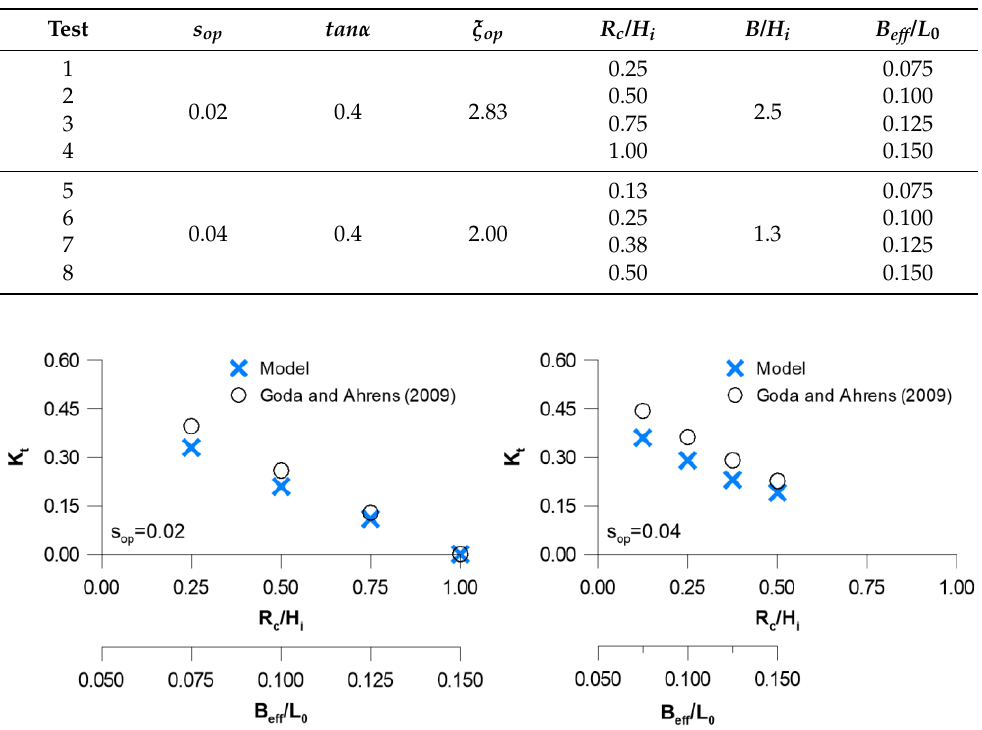
Figure 3. Governing parameters involved in wave transmission at emerged low-crested structures (LCS). Table 1. Values of the parameters in the wave transmission Tests ( s op = wave steepness; tan α = slope; ξ op = breaker parameter; R c /H i = relative freeboard; B/H i = relative crest width; B eff /L 0 = relative effective structure width).